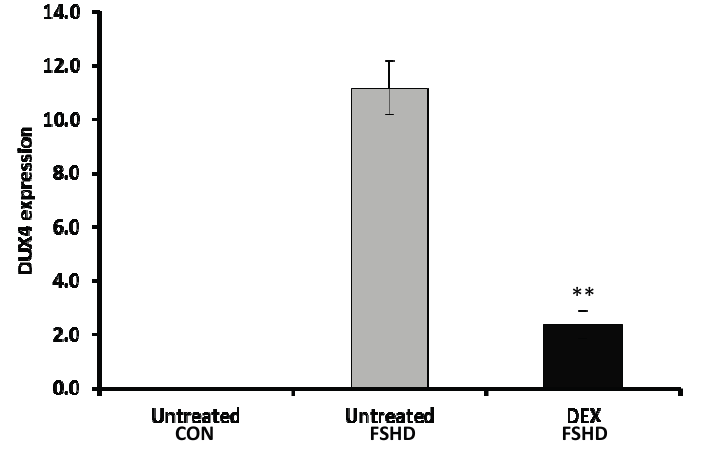
Figure 3. Dexamethasone reduced DUX4 expression in primary FSHD myoblasts. Control ( n = 5) and FSHD ( n = 5) myoblasts were cultured in growth medium with 15% KSOR, either with or without dexamethasone, respectively, for 3 days. DEX, dexamethasone; CON, control; “**”: p <